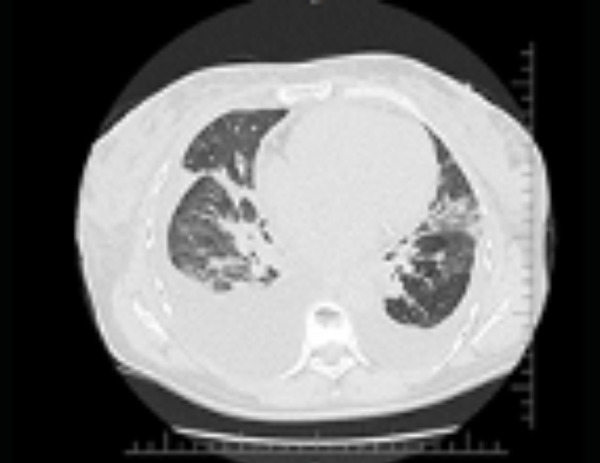
Chest tomography.